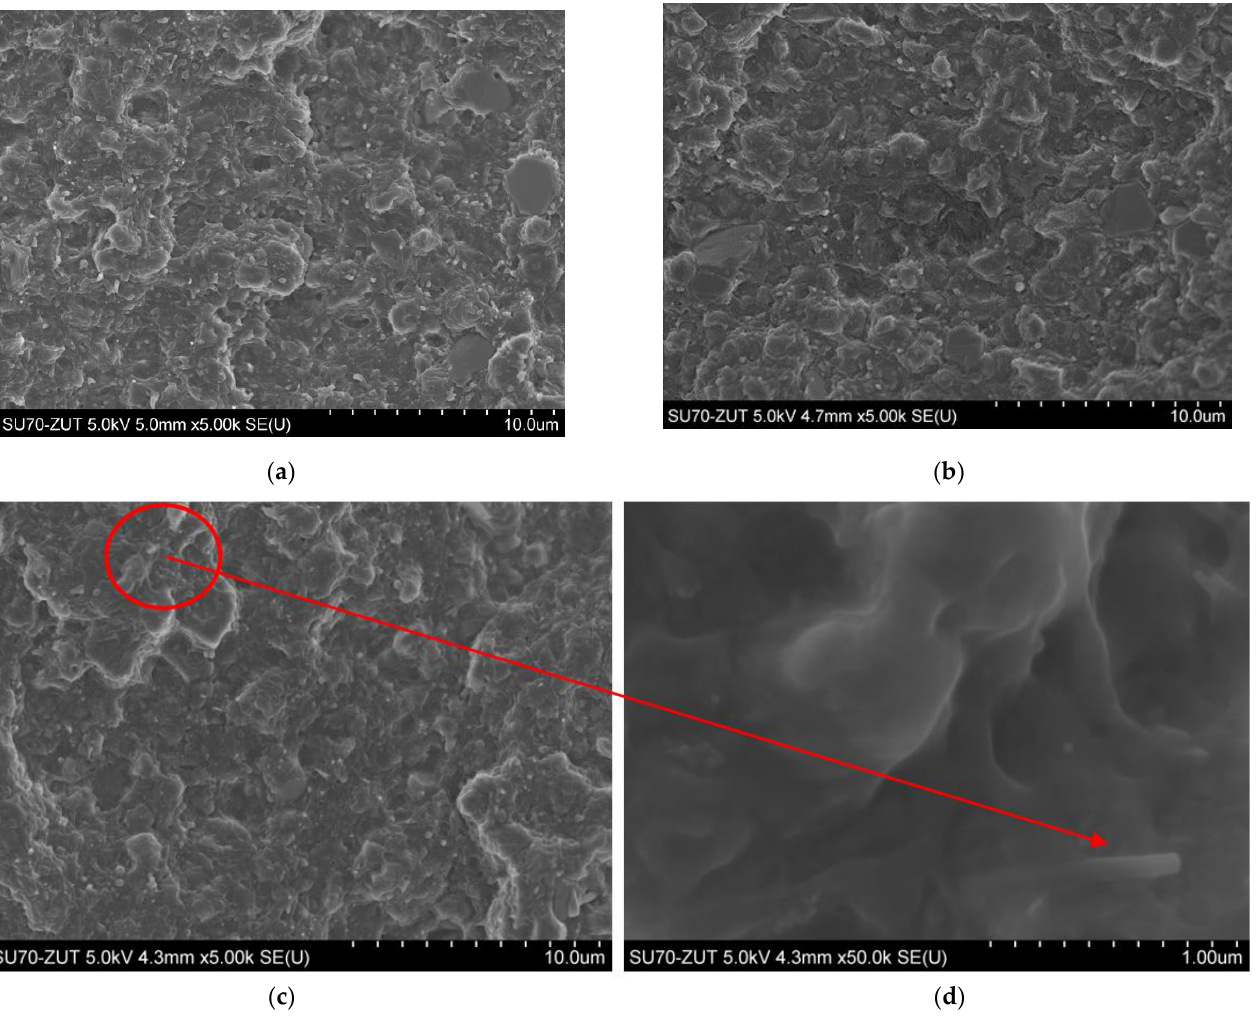
Figure 2. Scanning electron micrographs of ( a ) nanocomposite with 8% of HNTs (8HNT); ( b ) nanocomposite with 8% of ATH-sil (8ATH-sil); ( c , d ) hybrid nanocomposite with 12% of nanofillers (2:1) HNTs and ATH-sil (H12 2:1).